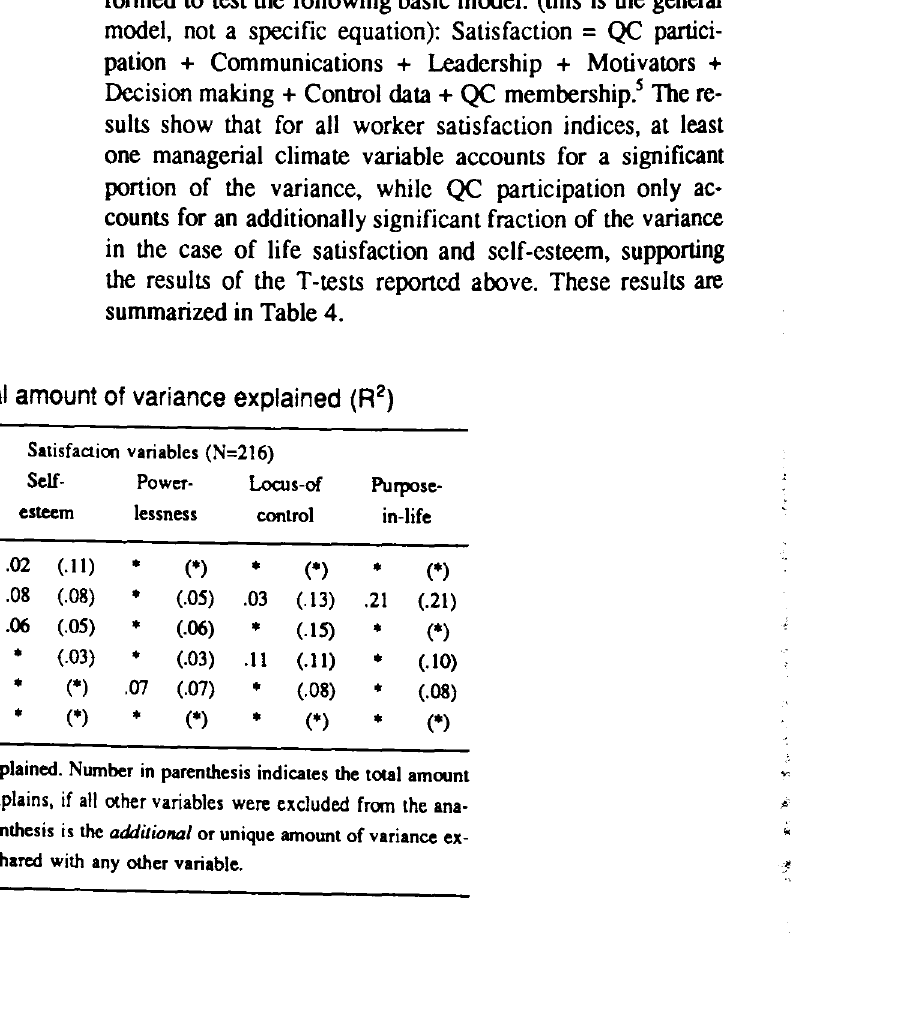
Figure 1 Satisfaction scores for QC and non-QC members